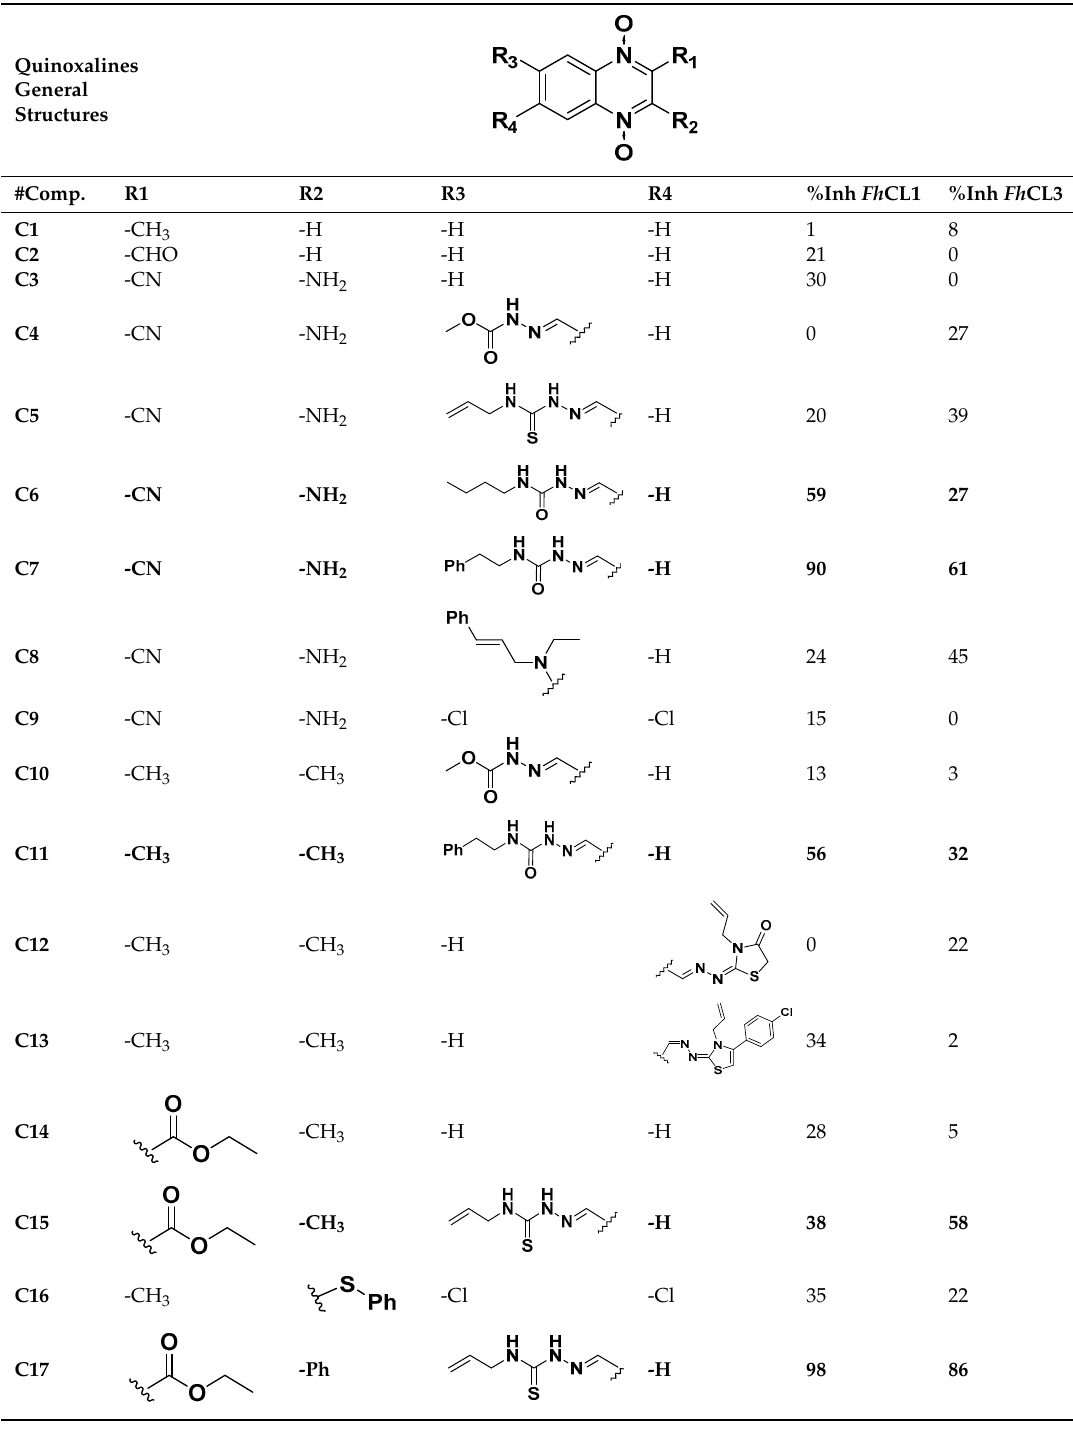
Table 1. Structures of quinoxaline 1,4-di- N -oxide derivatives evaluated as inhibitors of Fasciola hepatica cathepsins L1 and L3. Compounds were evaluated at 10 µM concentration, the percentage of inhibition is reported relative to the activity of the enzyme alone. The compounds with the highest inhibition are in bold. The whole structure of the compounds is given in Figure S1. The standard deviation is less than 10% for all compounds.